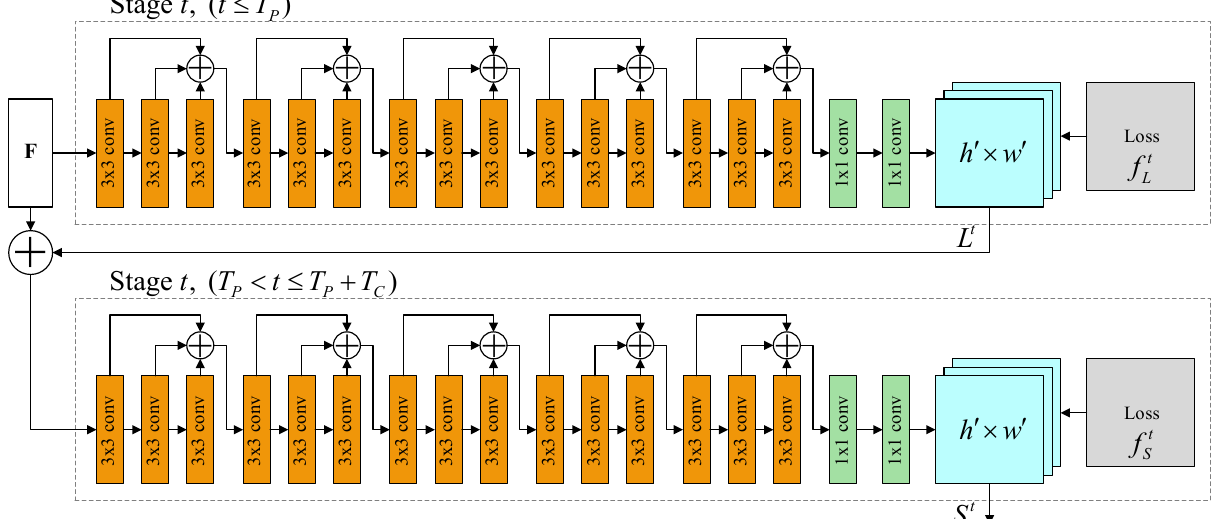
Figure 2. Network architecture of OpenPose